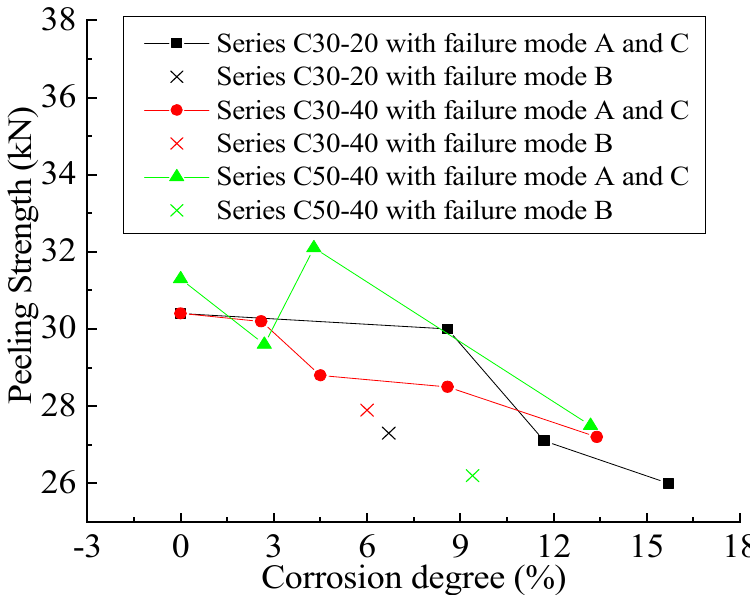
Figure 5. Combined effect of three factors on peeling strength.